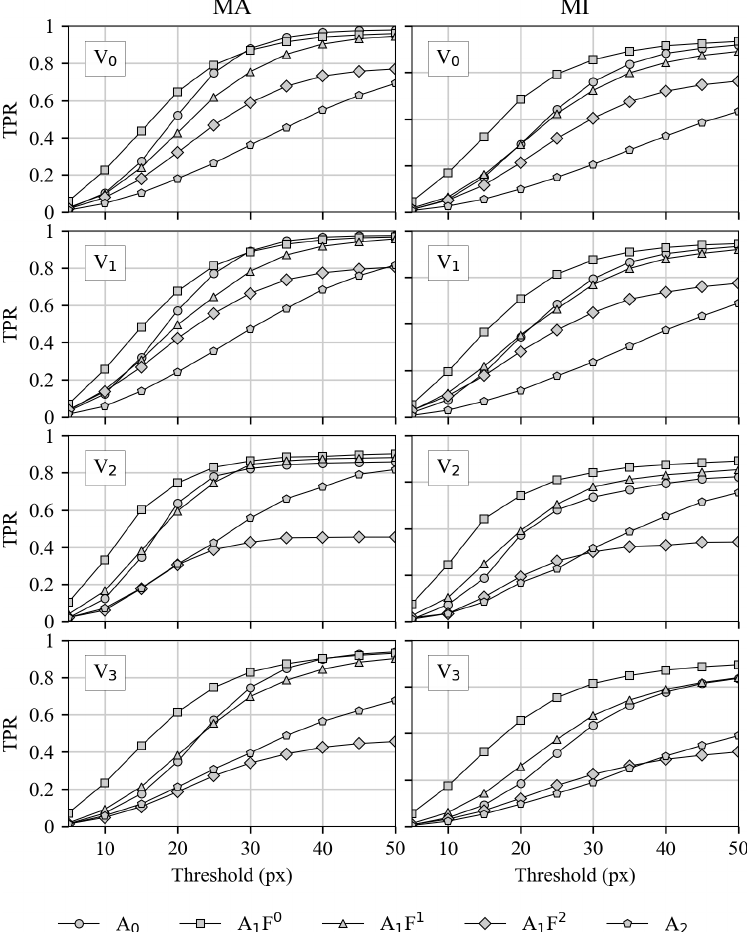
Figure 7. Recall for all investigated HPE-CNNs and videos at different thresholds with both matching variants. Detections with all labels (MA) is shown on the left, whereas MI is shown on the right. In rows, results for the four different videos are presented from top ( V 0 ) to bottom ( V 3